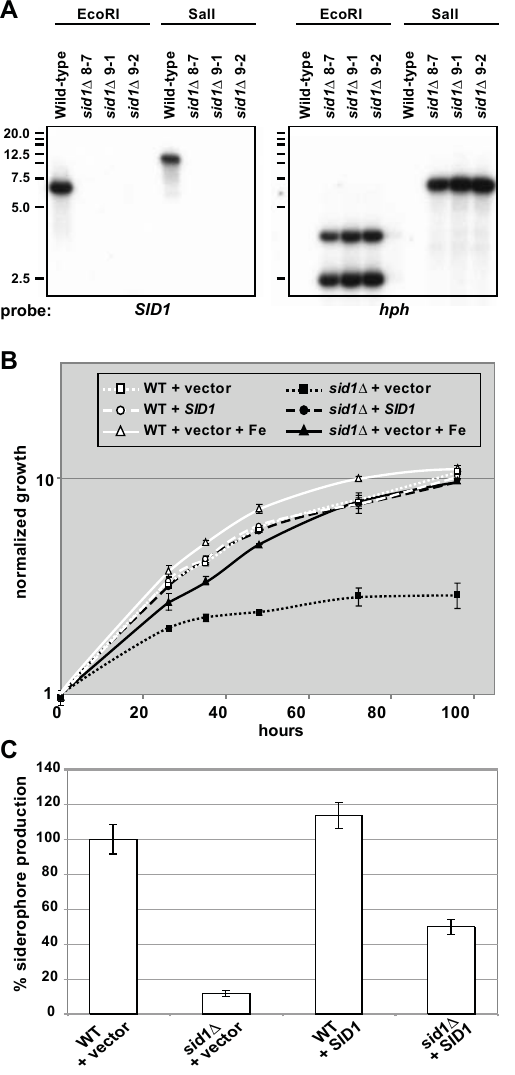
Figure 3. Disruption of SID1 Resulted in Iron-Dependent Growth and Defects in Siderophore Production. A. Southern analysis of SID1 disruption. Genomic DNA from parental strain (WU8- Wild-type) and potential sid1 D ::hph strains (HcLH25, HcLH26, and HcLH27) was digested by EcoR I or Sal I , separated by gel electrophoresis, blotted and hybridized to probes containing either the open reading frame of SID1 or the hph gene. For the SID1 probe, fragments of the expected sizes of 6.4 kb (EcoR I ) and 12.2 kb (Sal I ) are seen in the DNA from the parental strain. For the hph probe, fragments of the expected sizes of 3.6 kb and 2.3 kb (EcoR I ) and 6.8 kb (Sal I ) are seen in the DNA from sid1 D strains. B. Growth curves of HcLH95 (WT + vector), HcLH97 ( sid1 D + vector), HcLH103 (WT + SID1), and HcLH106 (sid1 D + SID1 ). Yeast cells were grown in mRPMI medium (pH 6.5) without or with 5 m M FeSO 4 added ( + Fe). Growth and siderophore production experiments were repeated at least three times with two independent sid1 D strains and four independent complementation strains. Samples for OD 600 were taken in triplicate. The mean + / 2 standard deviation is indicated. A representative experiment is presented. C. Siderophore production of strains. Yeast cells (same strains used in B) were grown in mRPMI medium (pH 6.5) for 24 hours and culture supernatant was examined for presence of siderophores using chrome azurol S assay as described in Materials and Methods. Samples were taken in triplicate. The mean + / 2 standard deviation is indicated. Results are given as percentage of siderophore production compared with WT + vector.